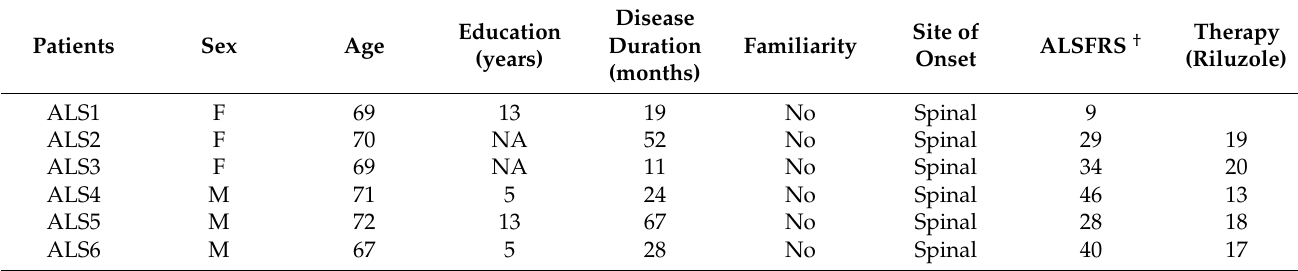
Table 6. Clinical characteristics of ALS subjects.